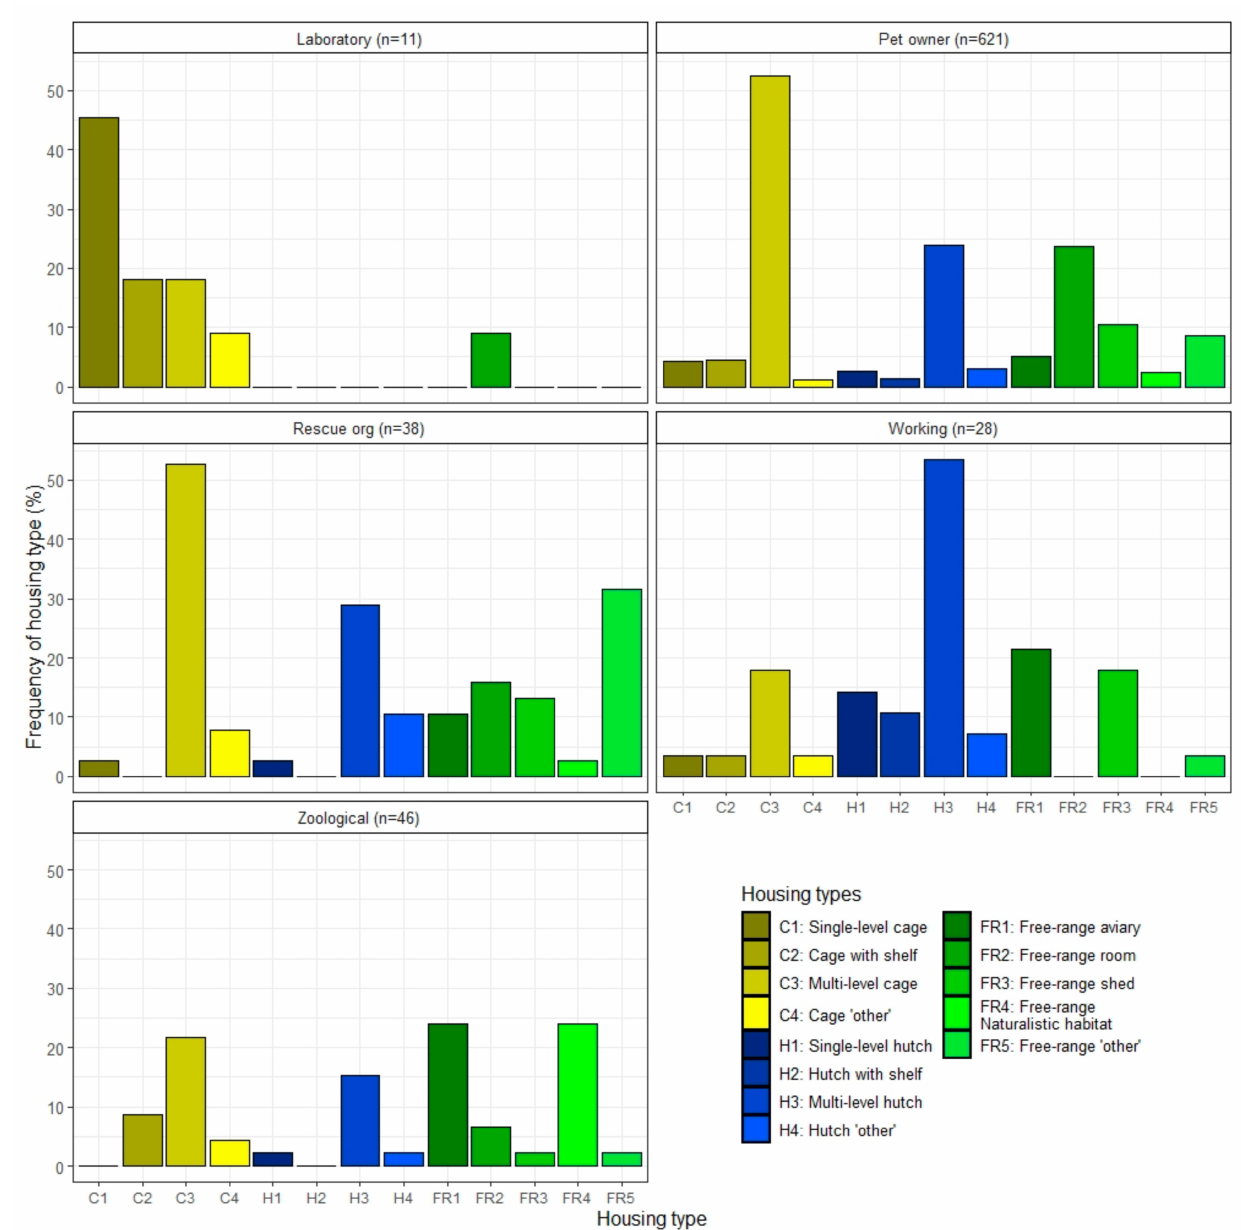
Figure 1. Percentage of housing types and sub-types by ferret caretaker sector. Housing types include cages (yellows), hutches (blues), and free-ranging (greens). Respondents could select all housing types which applied to them, resulting in a higher number of responses than the number of